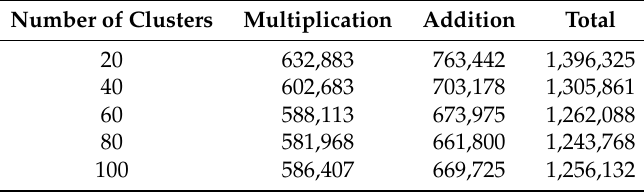
Table 3. Computational complexity according to number of clusters.